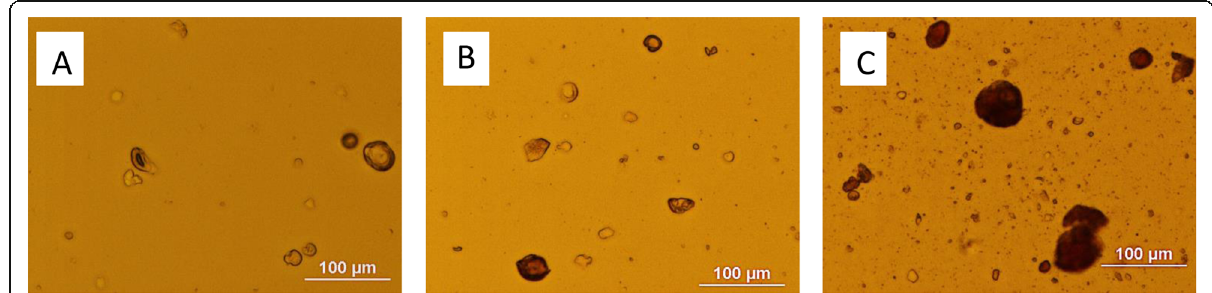
Fig. 5 Optical light microscope images at 200x magnification depicting the microstructures of diluted feed dispersions with 1:0 WPI:sucrose with 0% bioactives A , 0.5% bioactives B , and 1% bioactives from cranberry extract C . *COLOR USAGE